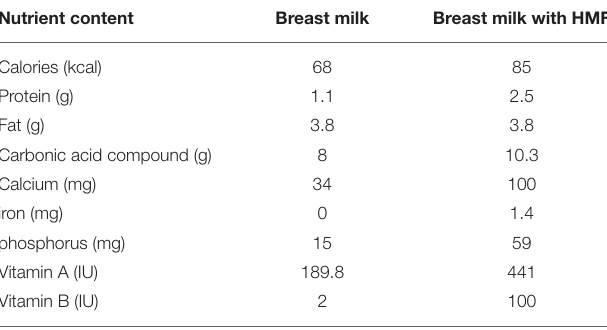
Intervention group